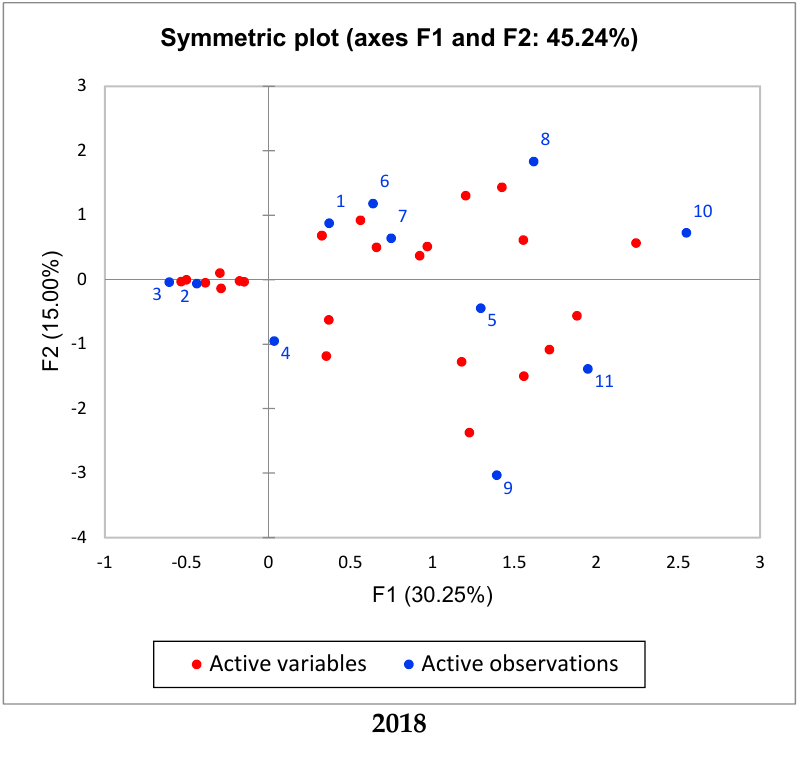
Figure A2. Factorial maps.